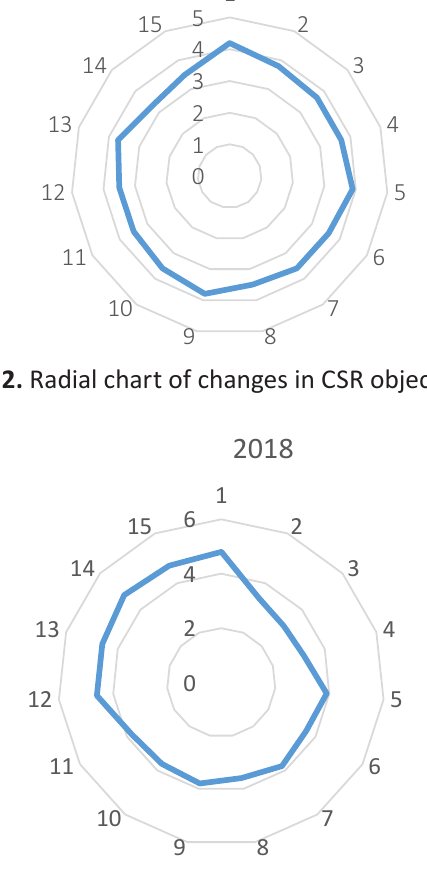
Figure 3. Radial chart of changes in CSR objectives (2018)